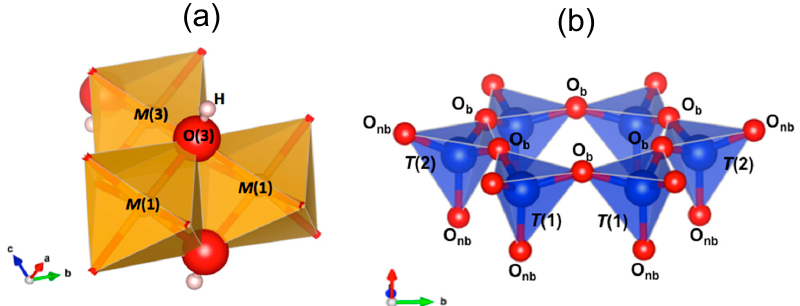
Figure 1. ( a ) Local octahedral configuration around the OH group in amphiboles. ( b ) Schematic representation of part of the double-chain of tetrahedra in amphiboles. O b = bridging oxygen, O nb = non bridging oxygen.